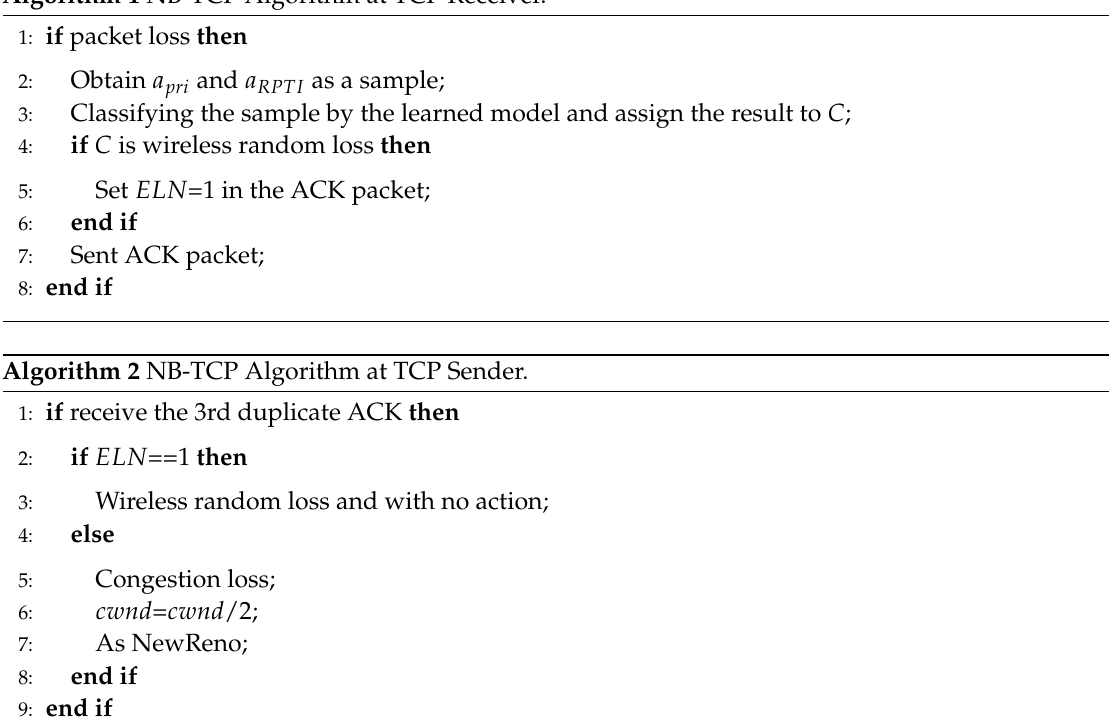
Algorithm 1 NB-TCP Algorithm at TCP Receiver.